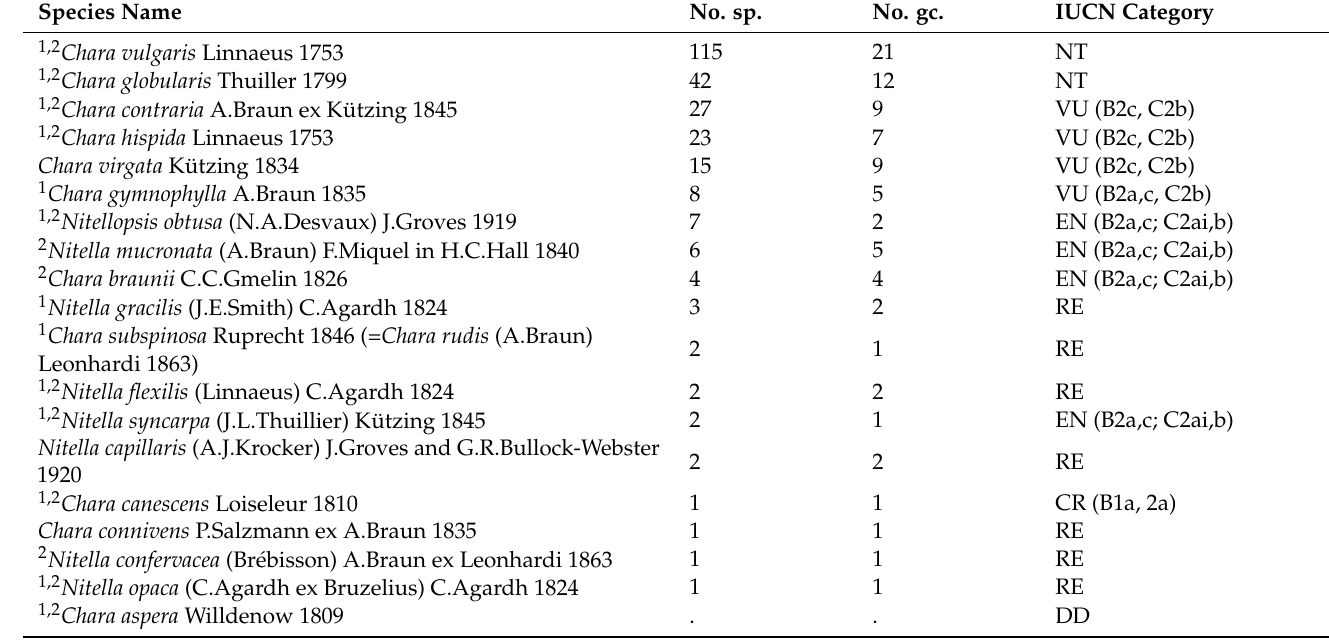
Table 1. Checklist and red list of charophytes in Slovakia with the number of its determined herbarium specimens and grid cell occurrence. Species signed as 1 and 2 were mentioned in previous Check List (1: Hind á k and Hind á kov á 1998) and red list (2: Hind á k and Hind á kov á 2001). No. sp. = number of specimens, No. gc. = number of grid